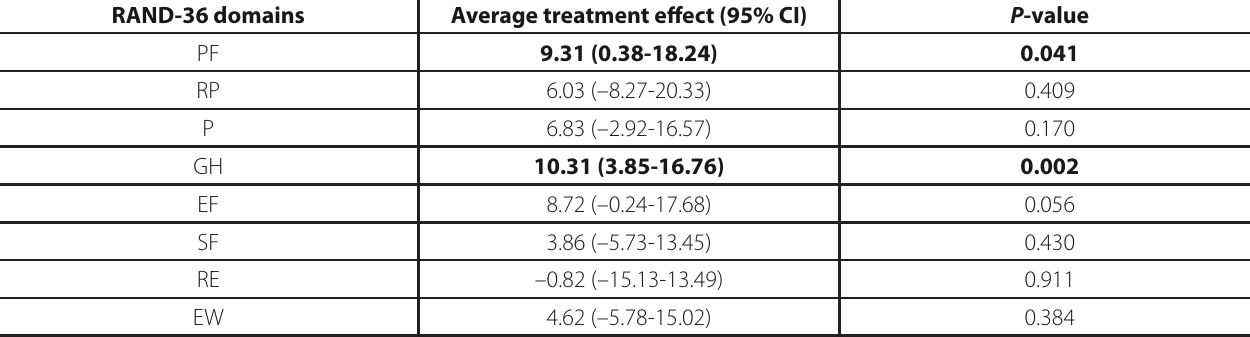
Table 6. Treatment effects on the RAND-36 domains of no-touch versus conventional vein graft (propensity score matching). RAND-36